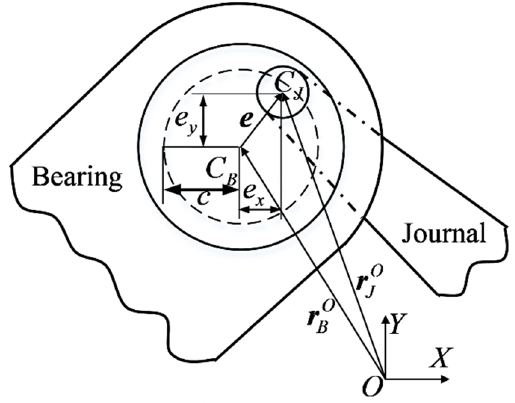
Figure 1. Clearance joint model.